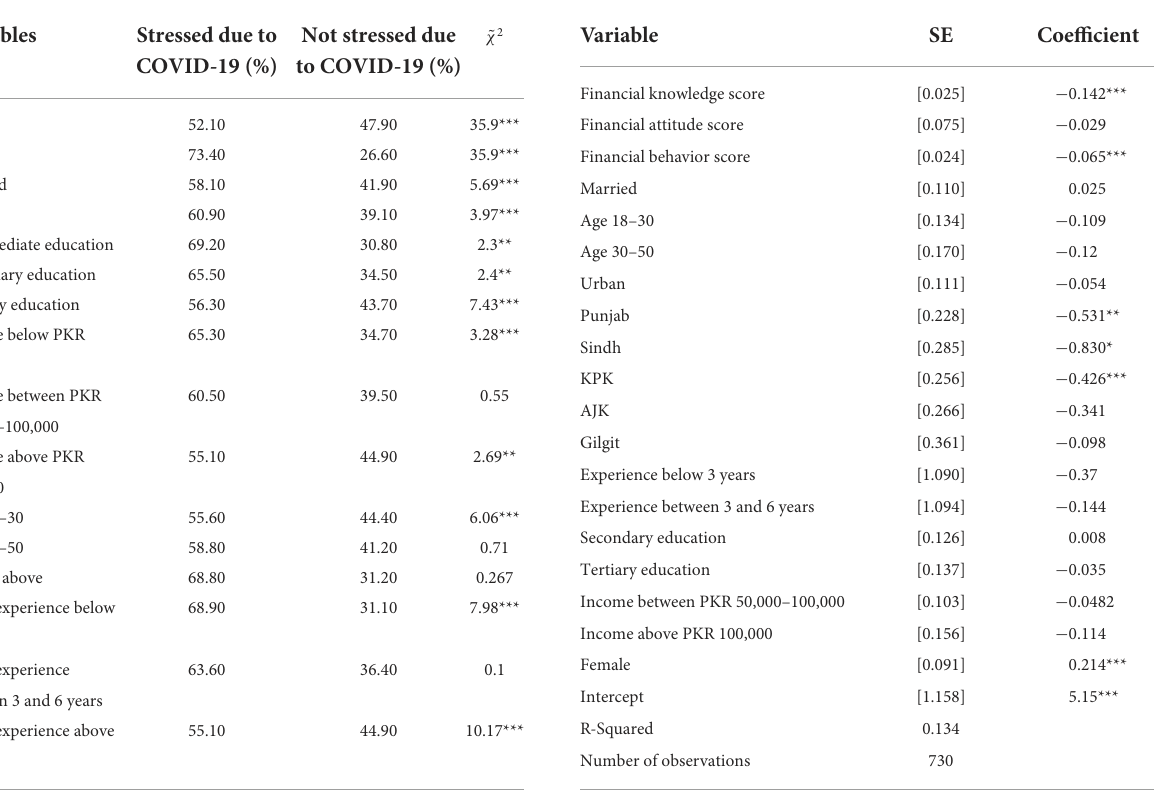
TABLE 3 Percentage of sample stressed and non-stressed due to COVID-19.